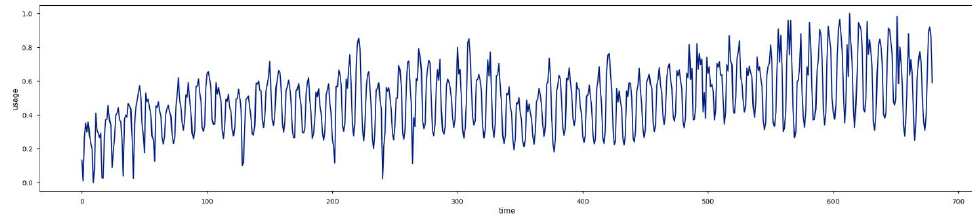
Figure 1. Example of normalized electric power usage